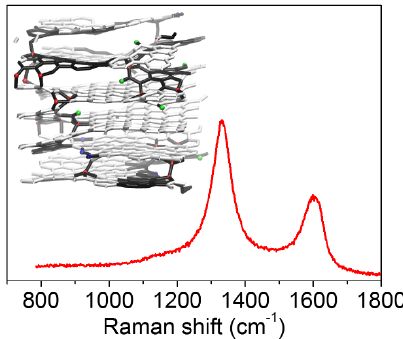
Figure 20. Raman spectrum obtained from a pyrocarbon. The inset represents a rough laminar pyrocarbon with defects ( black bonds ), sp 3 bonds ( blue ), sp bonds ( red ), and hydrogen bonds ( green ). ( λ 0 = 633 nm).